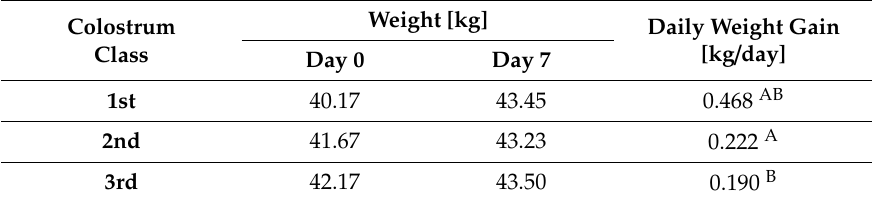
Table 4. Changes in calf weight depending on the cows’ colostrum class.